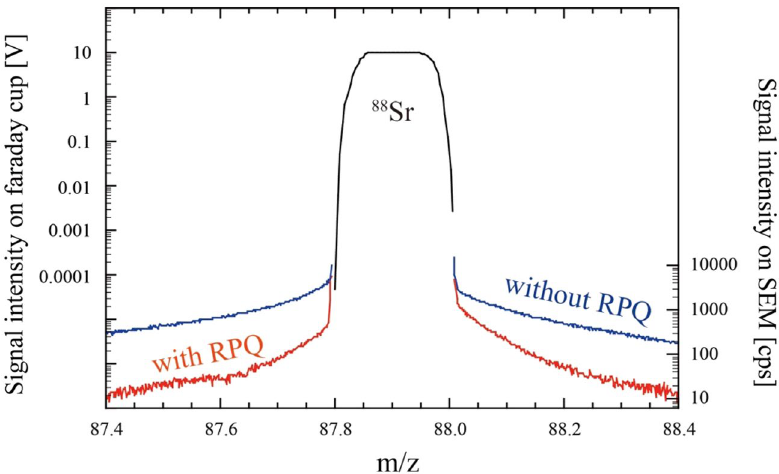
Figure 1. Mass spectrum in the vicinity of m/z = 88 showing the flat-top peak of 88 Sr measured by the center Faraday cup (black lines). The 88 Sr peak tails on the low- and high-mass sides is also shown. Peak tails measured by SEM without the RPQ are shown in blue lines and peak tails measured by SEM with the RPQ are shown in red